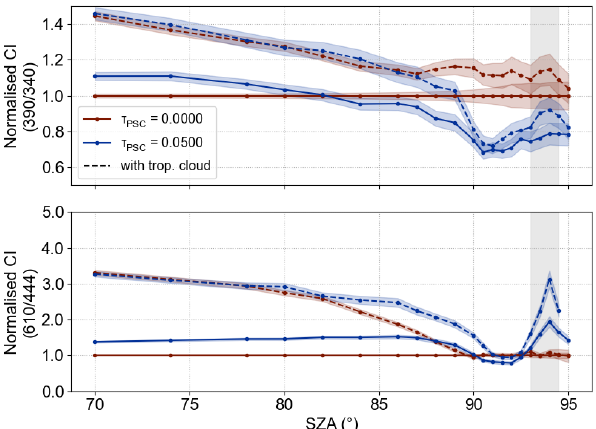
Figure 4. Simulation result (normalised CI) with a tropospheric cloud layer shown for the non-PSC case ( τ PSC = 0 . 00) and a PSC layer ( τ PSC = 0 . 05) at h PSC = 20 to 22km. Dashed lines represent simulations with a tropospheric cloud layer at 3.0 to 4.0km (AOD = 5) compared to unaffected simulations (solid